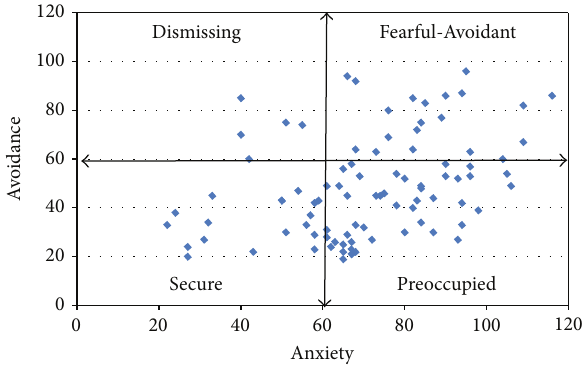
Figure 2: Distribution of the dimensions “Avoidance” and “Anxiety” from the ECR in PND